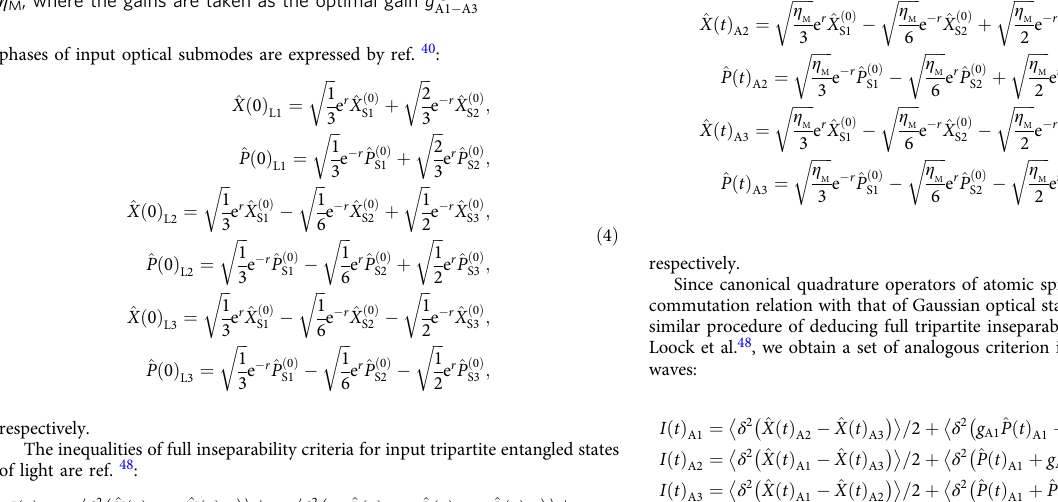
Fig. 4 The dependence of combination of normalized quantum correlation variances among three atomic ensembles after a storage time of 1000 ns on the squeezing parameter r of three DOPAs and the mapping ef fi ciency η M , where the gains are taken as the optimal gain g